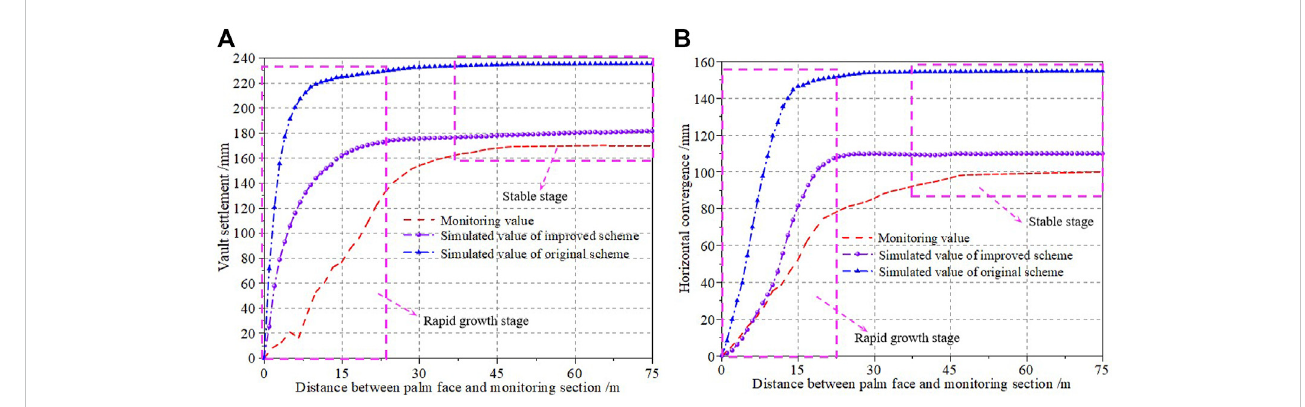
FIGURE 10 Variation of surrounding rock deformation: (A) vault settlement and (B) horizontal convergence.